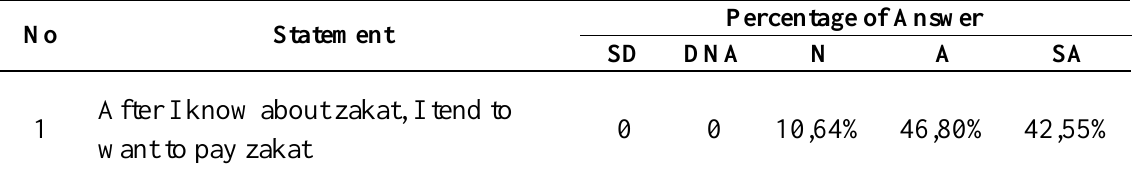
Table 6: Variable Description of Intention to Pay